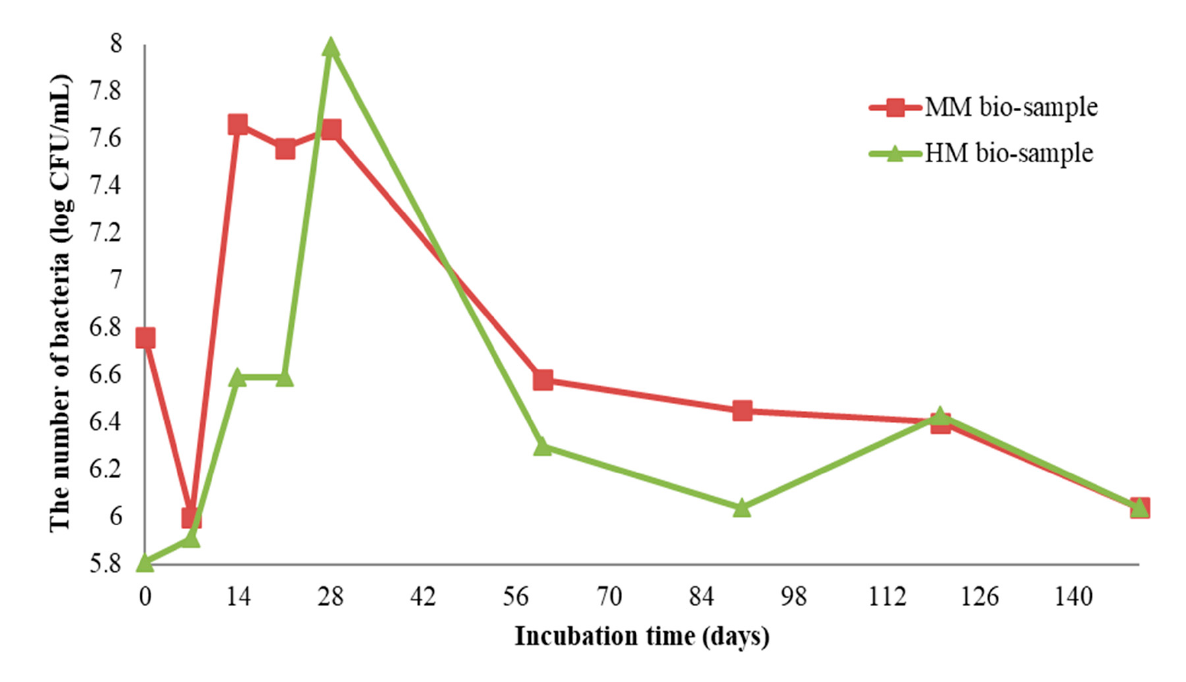
Figure 6. Enumeration of S. pasteurii DSM 33 on MM and HM bio-samples [6].